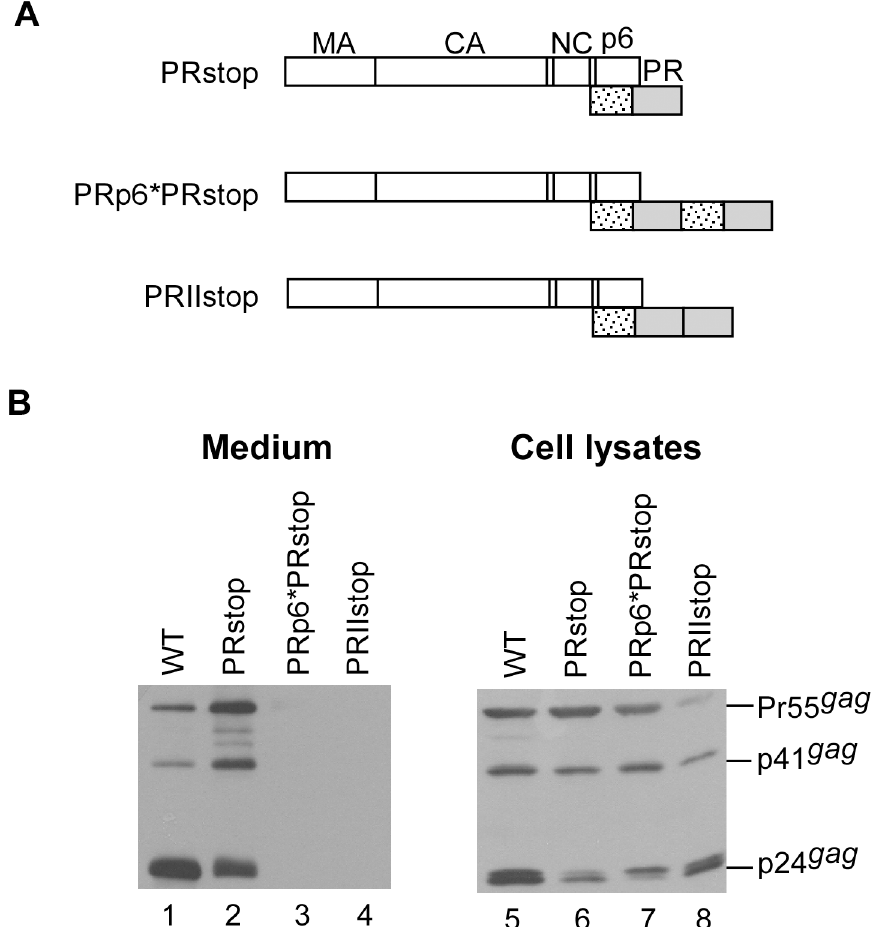
Fig 3. Removal of PR downstream sequences did not significantly impact enhanced Gag cleavage by PR pairs. (A) Schematic representations of HIV-1 Gag and Gag-PR expression constructs. PRstop contained a stop codon insertion at the PR-RT junction (codon sequence 5 ’ TTTCCCATTAGCCCTTAG-3 ’ ); RT codons are underlined. Recombining the PRstop with PRp6 * PR or PRII (Fig 1) yielded PRp6 * PRstop and PRIIstop, respectively. (B) 293T cells were transfected with designated constructs. At 24 – 48 h post- transfection, cells and supernatants were collected and subjected to Western